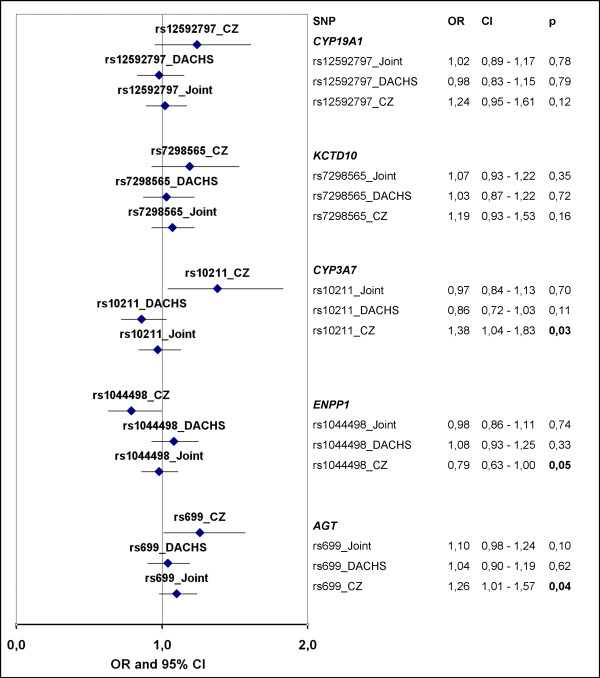
Comparative data plot of the OR and 95% CI of the SNPs analyzed in the Czech and the DACHS cohort; dominant model, individual Czech and DACHS data adjusted for age and sex; joint data adjusted for age and sex, stratified by study; CZ Czech cohort; OR odds ratio; CI confidence interval.